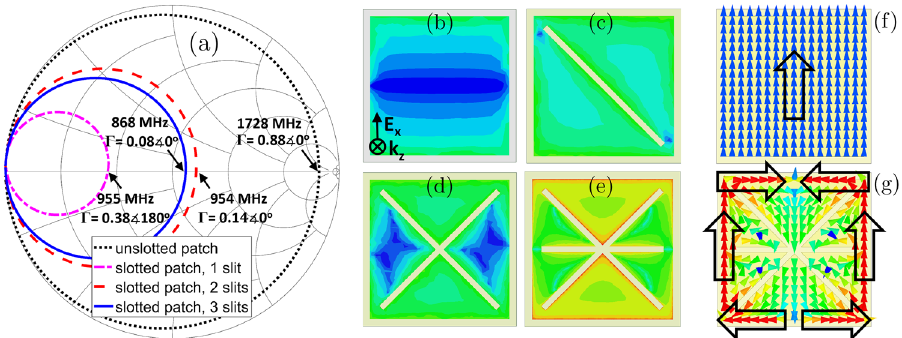
Figure 3. ( a ) Loci of Ŵ ( ω ) in Smith-chart for the unit-cell design evolution; E-field distribution on the top surface of the unit-cell design steps for a normal incident planewave at 868 MHz towards the: ( b ) unslotted patch; ( c )–( e ) slotted patch with one, two, and three slits, respectively. Vector current distribution on the top surface of the ( f ) unslotted patch and ( g ) proposed unit-cell illuminated by x -polarized normal incident wave at 868 MHz. Black arrows indicate the privileged orientation. Scale: logarithmic with 15 subdivisions ranging from 10 5 V/m and 0.1 to 100 A/m. 3 to 3 ×